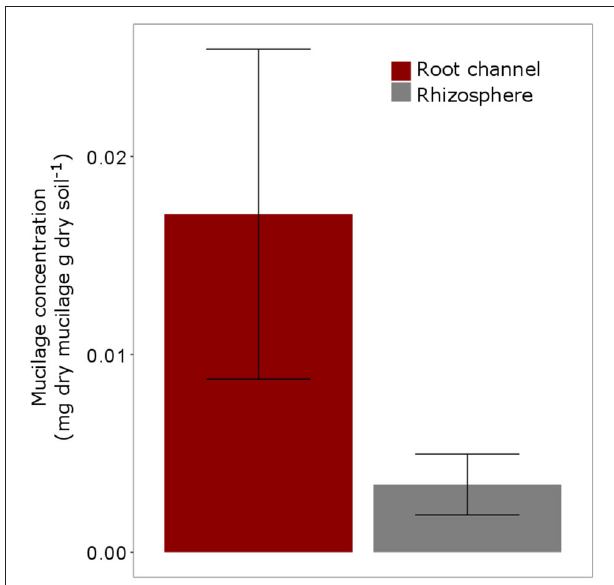
FIGURE 9 | Average Mucilage concentration (mg dry mucilage per g dry soil) for all measured positions ( = 3) and all plants (5 replicates). “Root channel” refers to the measurements within the root channel (soil that had been in direct contact with the root). “Rhizosphere” refers to the soil 1mm ( = 10 measurements) beyond the root channel border, corresponding to the region defined as “rhizosphere” in Figure 3 ). Variation is given as standard error. Differences between Root channel and rhizosphere were not statistically different ( p <